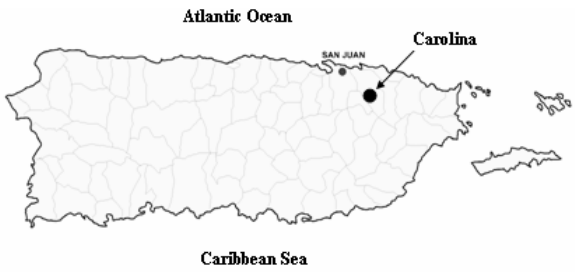
Figure 1: Map illustrating the geographic location of the school that participated in this study. School was located in Carolina, Puerto Rico, a municipality that has the Atlantic Ocean on the north, the Caribbean National Forest on the east, the Sierra de Luquillo mountains on the South and the capital of Puerto Rico, San Juan, on the west.